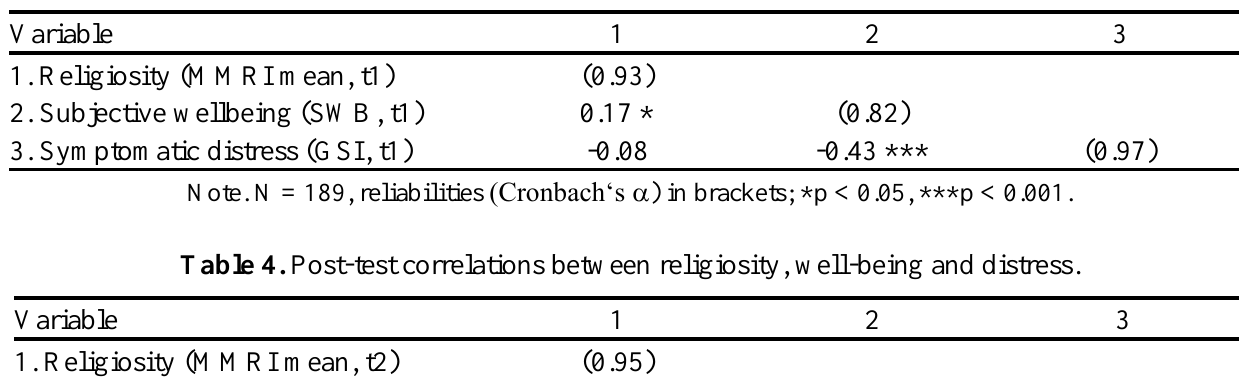
Table 3. Pre-test correlations between religiosity, well-being and distress.